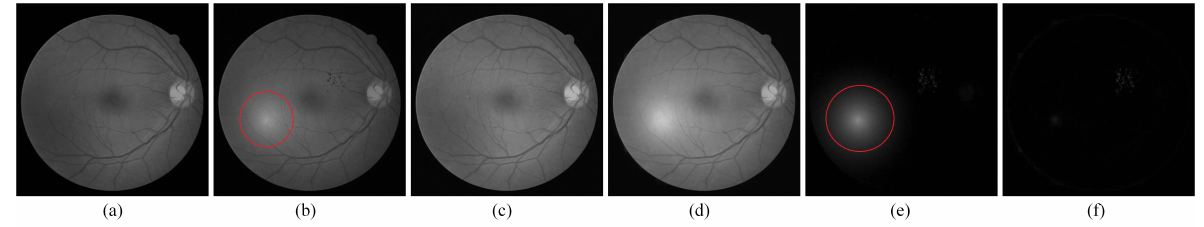
Figure 5. The result of the image with small lesions by RPCA method. ( a ) Normalized reference image; ( b ) normalized current image; ( c ) reconstructed low-rank background by RPCA; ( d ) reconstructed low-rank background by P-RPCA; ( e ) sparse change regions by RPCA; and ( f ) sparse change regions by P-RPCA. The red circle marks the distraction of flare in the current image for the RPCA